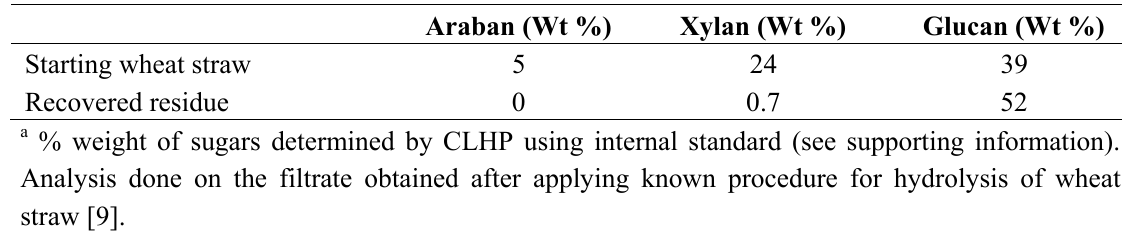
Table 2. Composition of wheat straw and residue a .